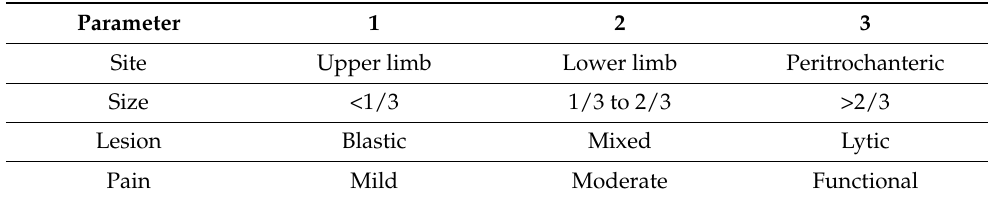
Table 1. Mirels’ scoring system for identifying impending fractures: ≥ 9 high risk for pathologic fracture, >8 intermediate risk for pathologic fracture, ≤ 7 low risk for pathologic fracture [9]. Parameter 1 2 3 Site Upper limb Lower limb Peritrochanteric Size <1/3 1/3 to 2/3 >2/3 Lesion Blastic Mixed Lytic Pain Mild Moderate